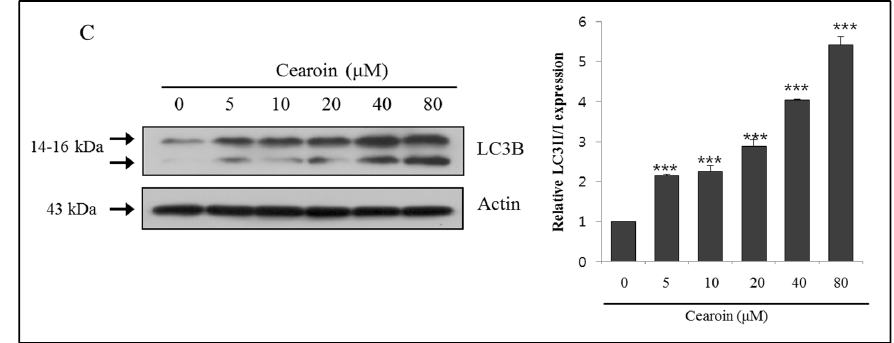
Figure 2. Cearoin induces the phosphorylation of ERK and the formation of LC3B-II. SH-SY5Y neuroblastoma cells were treated with cearoin in various concentrations (0, 5, 10, 20, 40, or 80 μ M) and incubated for 12 h. Then the cells were lysed, and ( A ) the expression levels of p-ERK, p-JNK, actin; ( C ) LC3B I/II and actin were measured by Western blot analysis. The blots shown are representative of three independent experiments. Actin was used as a loading control; ( B ) quantification by densitometry.